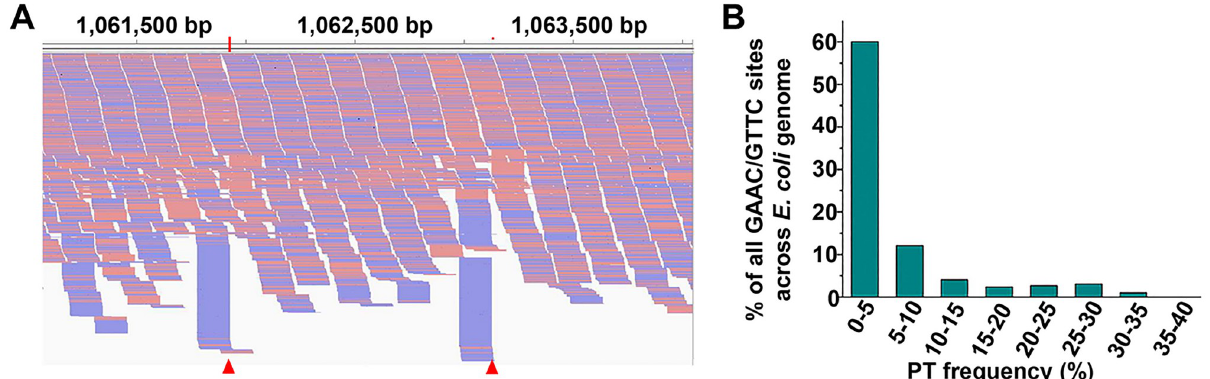
Fig 3. PT-IC-seq of E . coli B7A genome reveals low PT modification frequency globally. (A) The snapshot of genome browser representing partially modification site in bacteria genome. The top track shows counts of 5’ ends in the selected region. Blue segments represent reads mapped to minus strand and red segments represent reads mapped to plus strand. The red triangle marks two partial PT sites in E . coli B7A genome (B) The ratio of the I 2 -specific-cleavaged reads to all the reads across the site and the PT ratio falling in the range of proportions. Statistics analysis of the PT modification frequency in the genomes of E . coli B7A. All of the PT modified sites in the genomes of E . coli B7A are partially-PT modified, and about 60% of the PT modified sites with the PT ratio lower than